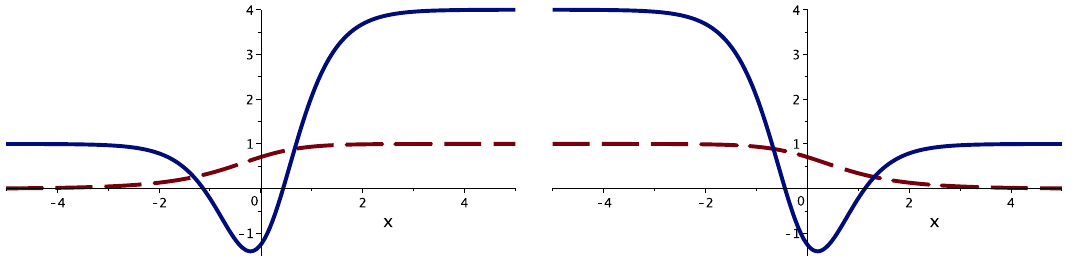
Figure 1 . The φ 6 model on the full line: a) (left) Static BPS kinks and antikinks on the full line, centered at x = 0. Plots are for Φ 1+ ( x ) (red dashed), Φ 2+ ( x ) (blue dash dotted), Φ 1 − ( x ) (black dotted), Φ 2 − ( x ) (green solid line). b) (right) Irregular solutions Φ 3+ ( x ) (red dashed), Φ 4+ ( x ) (blue dash dotted), Φ 3 − ( x ) (black dotted), Φ 4 − ( x ) (green solid line).